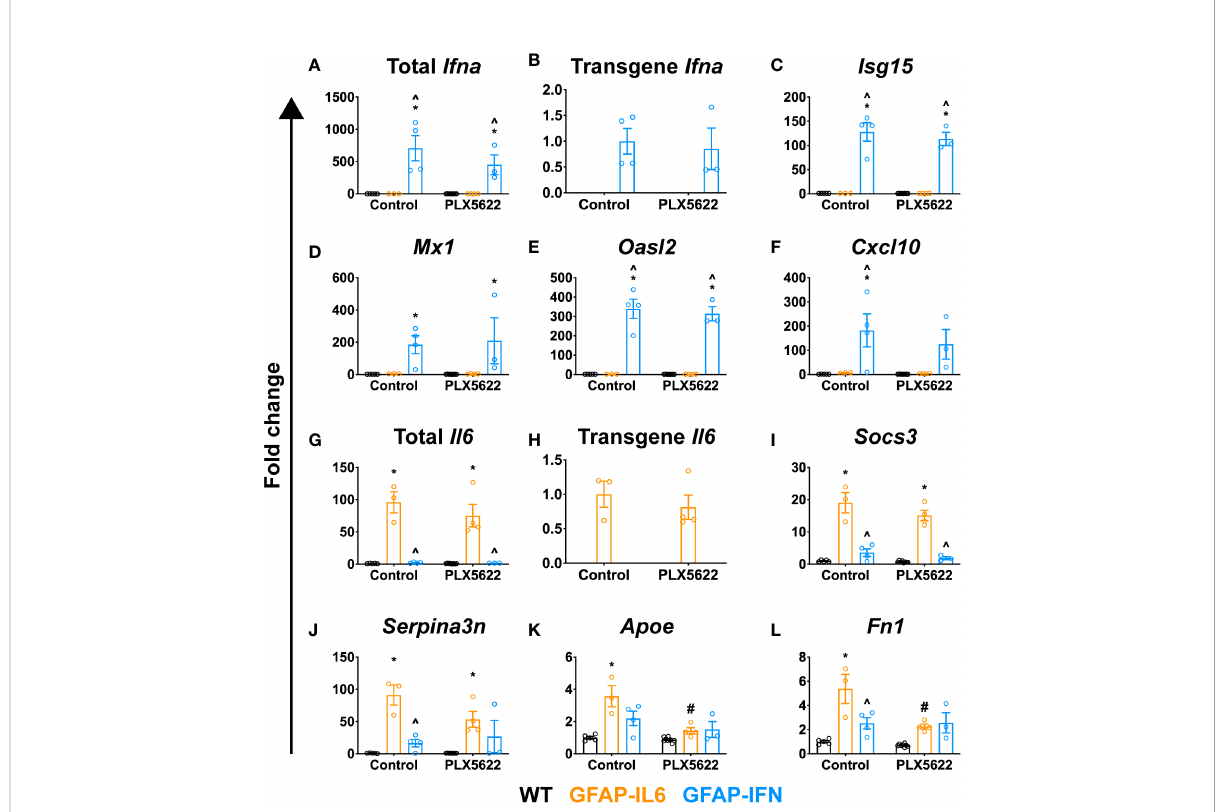
FIGURE 6 PLX5622-mediated ablation of microglia in the brain of GFAP-IL6 and GFAP-IFN mice does not alter the expression of IL-6 or IFN- a or their regulated genes. (A – L) qPCR of selected IL-6- and IFN- a -regulated genes in the cerebellum of WT, GFAP-IL6 and GFAP-IFN mice treated with control or PLX5622 diet for 12 weeks. (A – F) Fold change of IFN- a -regulated genes: (A) total Ifna , (B) transgene Ifna , (C) Isg15 , (D) Mx1 , (E) Oasl2 and (F) Cxcl10 . (G – L) Fold change of IL-6-regulated genes: (G) total Il6 , (H) transgene Il6 , (I) Socs3 , (J) Serpina3n , (K) Apoe and (L) Fn1 . In (B) , fold change is relative to untreated GFAP-IFN mice; in (H) , fold change is relative to untreated GFAP-IL6 mice; and in (A, C – G, I – L) , fold change is relative to untreated WT mice. n=3-8 mice/group. Graphs show individual values per mouse and mean ± SEM. *p<0.05 compared with WT of same condition; ^p<0.05 compared with GFAP-IL6 of same condition; # p<0.05 compared with untreated control of same genotype using two-way ANOVA with Tukey ’ s